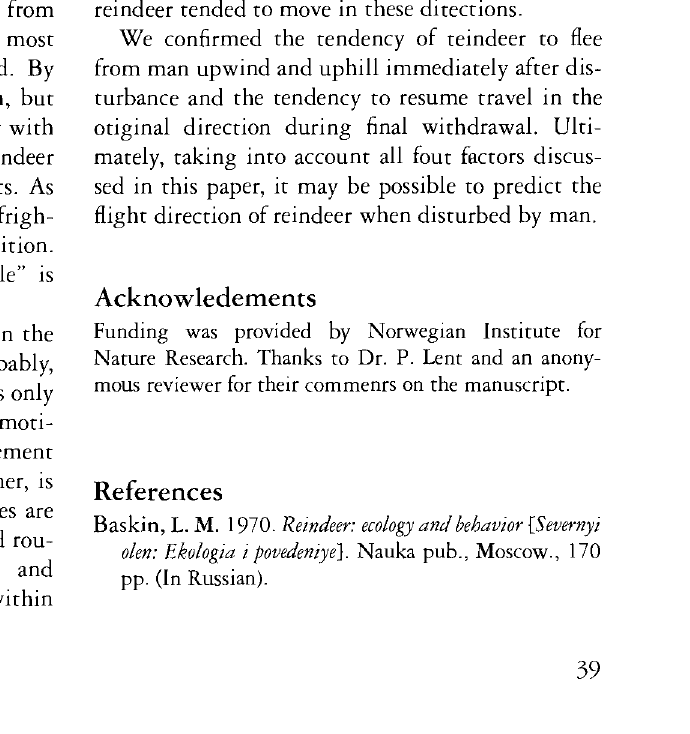
Table 2. Initial reaction of reindeer to human distur bance. % approaching man Feral reindeer Wild